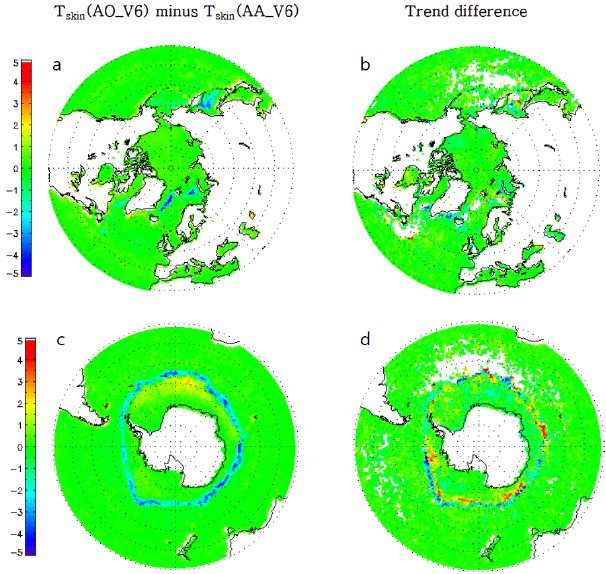
Figure 11. Same as Fig. 10 except for T skin (AO_V6) minus T skin (AA_V6). (a) is the same as Fig. 3c in Kang and Yoo (2015). cooling trend (i.e., warmer direction) as − 0.96, − 0.66,